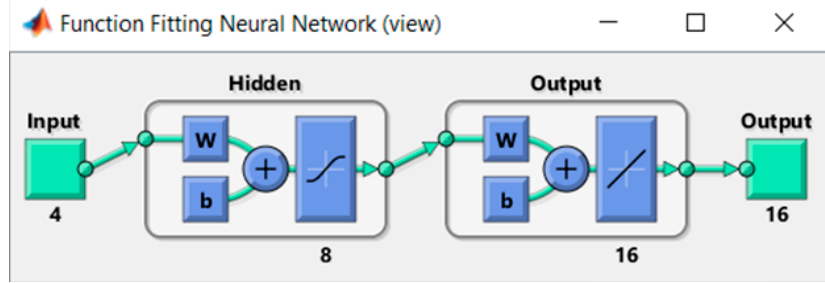
Table 6. Artificial Neural Network (ANN) Input Training Data